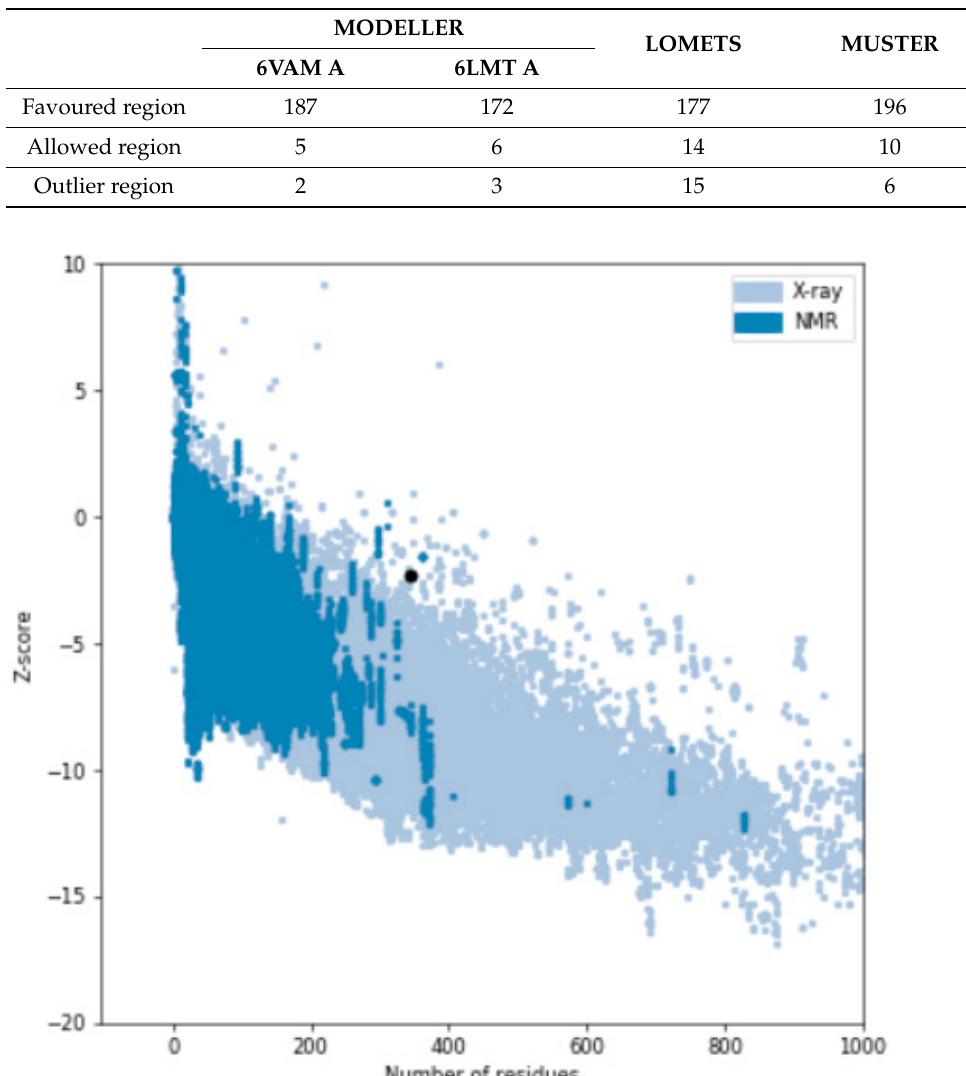
Table 2. Ramachandran plot for each model.